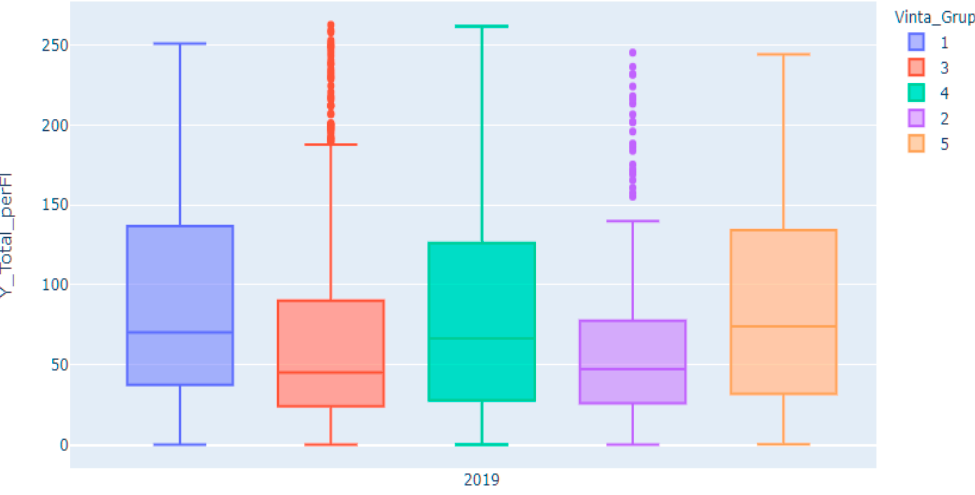
Figure 9. A box plot of annual energy consumption per unit area by vintage group in 2019.